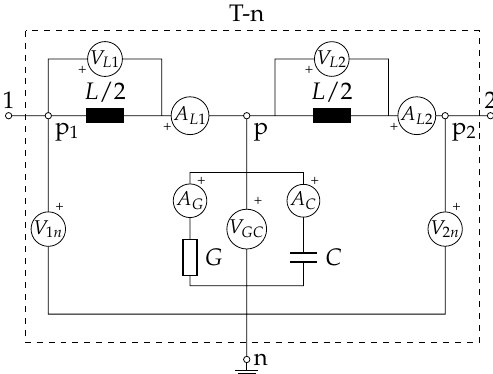
Figure 1. Element lenght in per-unit grounding wire illustration of implementation.